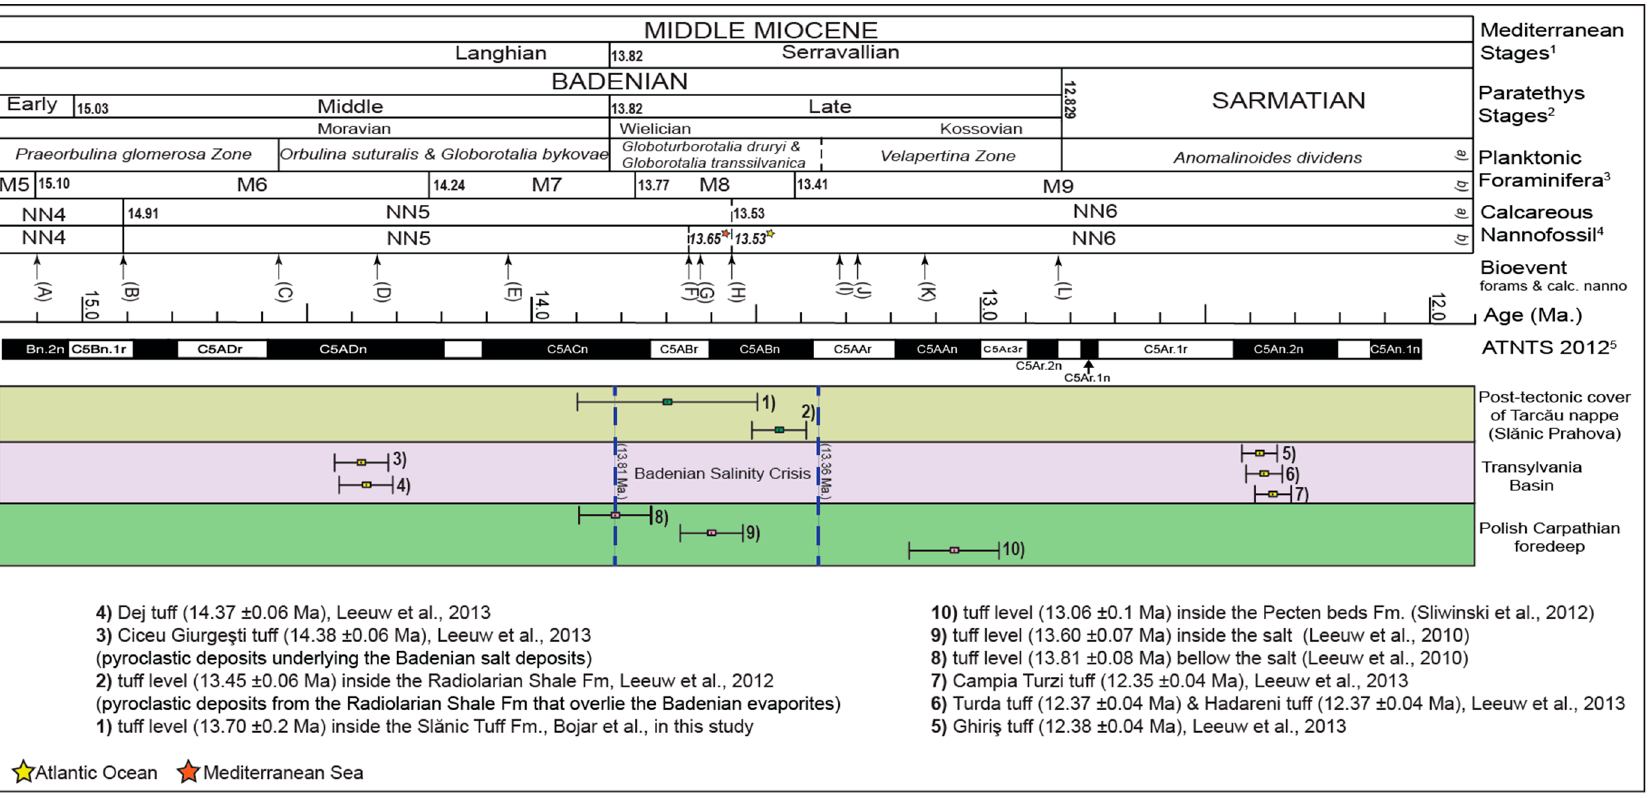
Figure 6. Geochronological and lithostratigraphical position of the investigated tuff level and regional correlations. ( 1 ) and ( 5 ) after [30]; ( 2 ) after [31]; ( 3a ) after [28] and ( 3b ) after [47]; ( 4a ) [34] vide [31] ; ( 4b ) after [48]; ( 5 – 9 ) after [46] and ( 10 ) after [49]. General bioevents: ( A ) FO Praeorbulina glomerosa , 15.01 Ma, Western Mediteraneean, [50]; ( B ) HO Helicosphaera ampliaperta , 14.91 Ma [51]; ( C ) FO Orbulina suturalis , 14.56 Ma, Western Mediterranean [50]; ( D ) LOC Helicosphaera waltrans , 14.35 Ma, Western Mediterranean [50]; ( E ) FCO Helicosphaera walbersdorfensis , 14.053 Ma, Western Mediterranean [50]; ( F ) HO Sphenolithus heteromorphus , 13.65 Ma, Eastern Mediterranean [51]; ( G ) LCO Sphenolithus heteromorphus , 13.63 Ma, Western Mediterranean [50]; ( H ) HO Sphenolithus heteromorphus , 13.532 Ma, Atlantic [51]; ( I ) LCO Cyclicargolithus floridanus , 13.30 Ma, Western Mediterranean [50]; ( J ) HCO Cyclicargolithus floridanus , 13.28 Ma, Eastern Mediterranean [51]; ( K ) FCO Reticulofenestra pseudoumbilicus , 13.13 Ma [50]; ( L ) base Reticulofenestra pseudoumbilicus , 12.83 Ma [52]. Absolute age data: Polish Carpathian foredeep [46,51]; Transylvania basin [3]; Sl ă nic Prahova [33].